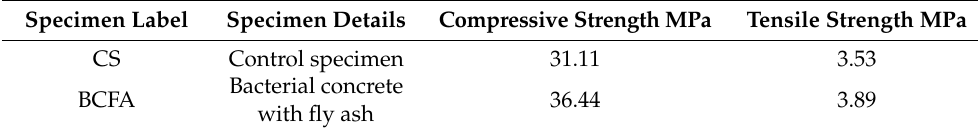
Table 1. Mechanical Properties of Concrete for Verification